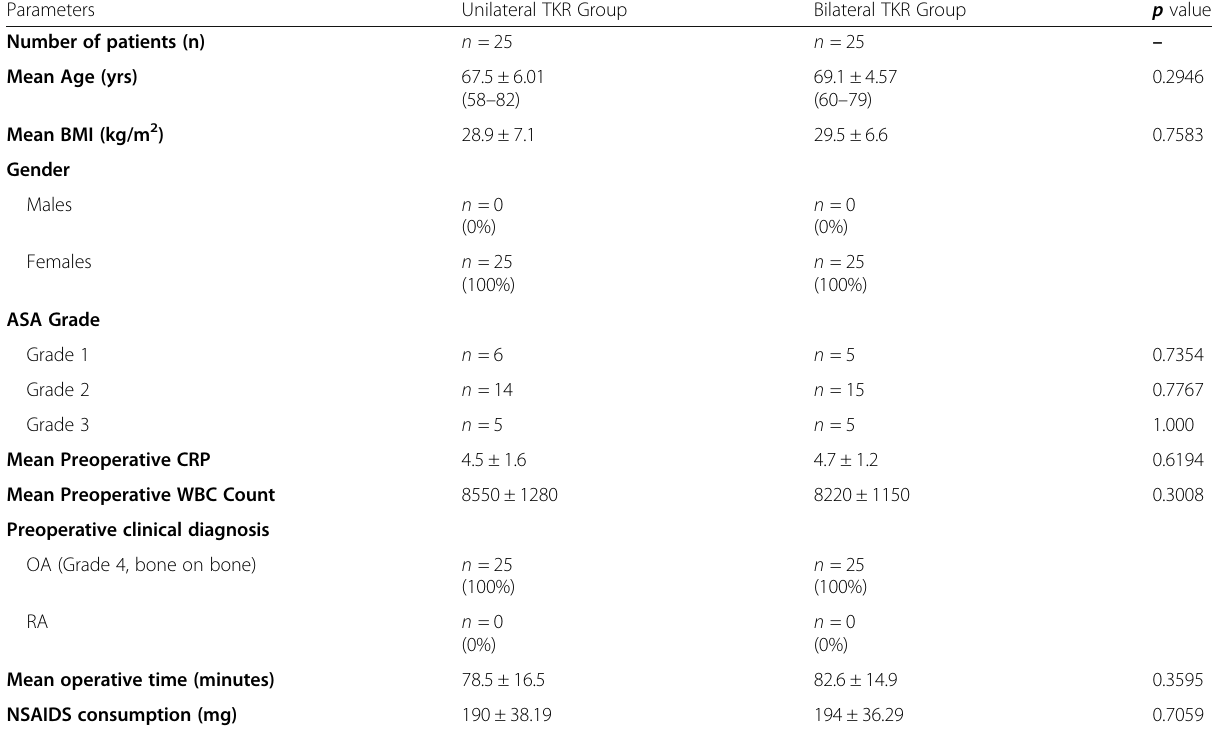
Table 1 Comparison of patient characteristics between Unilateral and Bilateral TKR group Parameters Unilateral TKR